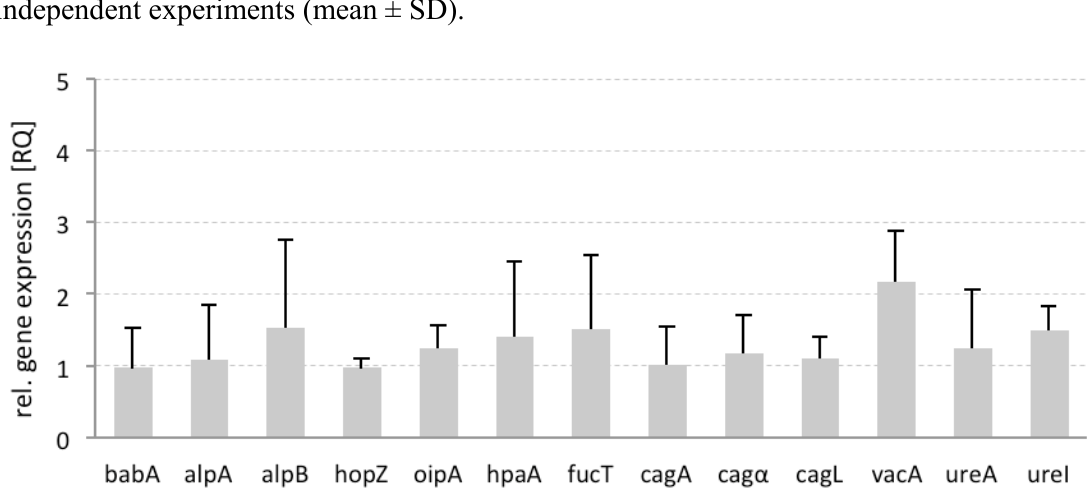
Figure 9. Differential gene expression of H. pylori pretreated with arabinogalactan protein F2 from R. nigrum . Endogenous control: 23S rRNA. Data are related to untreated control (UC) H. pylori in liquid growth medium (RQ = 1), with n = 2 replicates from three independent experiments (mean ±